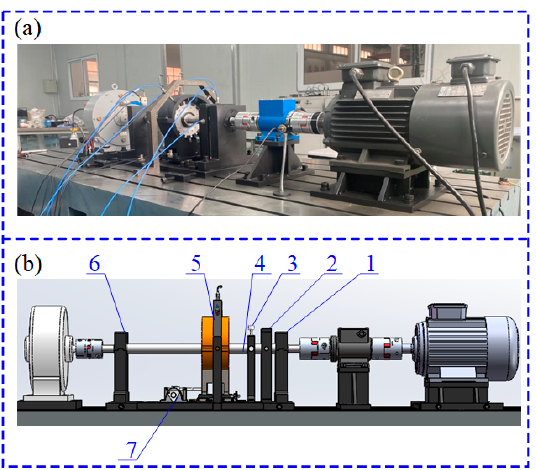
Figure 7. The rolling bearing experiment system: ( a ) the experimental test rig; ( b ) the layout of the test